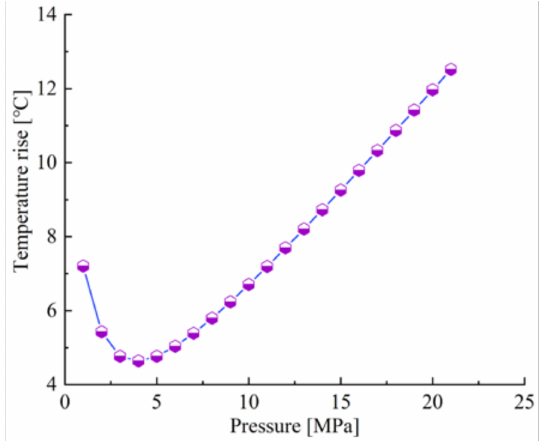
Figure 8. Variations in the temperature rise of the oil film of the valve pair.